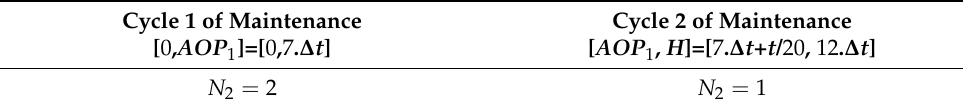
Table 15. Optimal number of preventive maintenance activities ( N = 3 ).